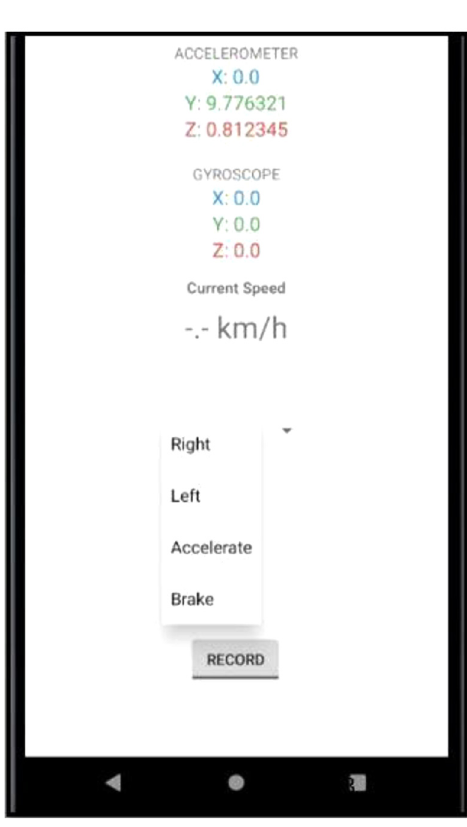
Figure 1. Screenshot of App. The figure shows the user interface of the data gathering app where readings from the smartphone’s accelerometer and gyroscope are updated in